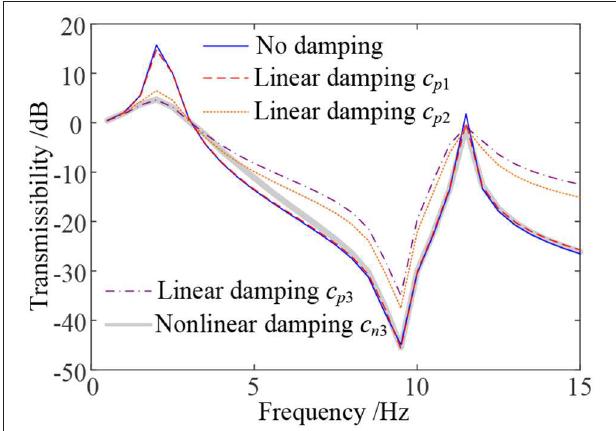
FIGURE 4 | Force transmissibility under linear and non-linear damping-based semi-active isolators.